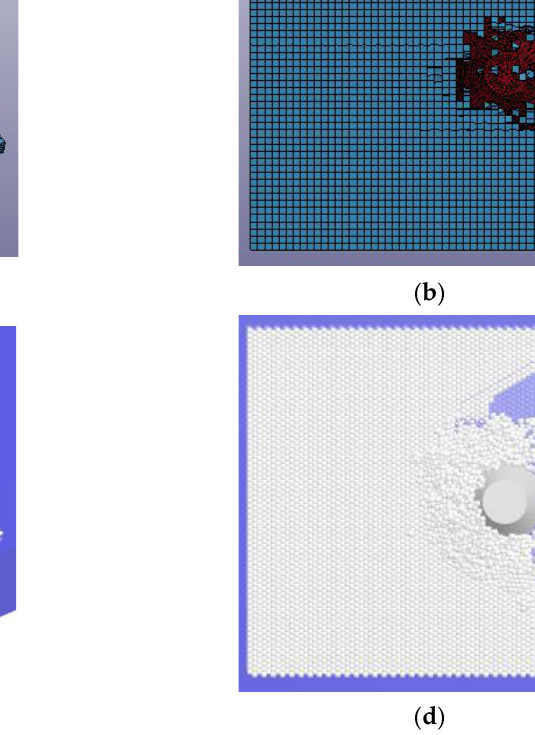
Figure 6. Simulation of interaction between cone structure and level ice. ( a ) Schematic diagram of finite element method calculation; ( b ) top view of finite element method calculation; ( c ) schematic diagram of discrete element method calculation; ( d ) top view of discrete element method calculation.